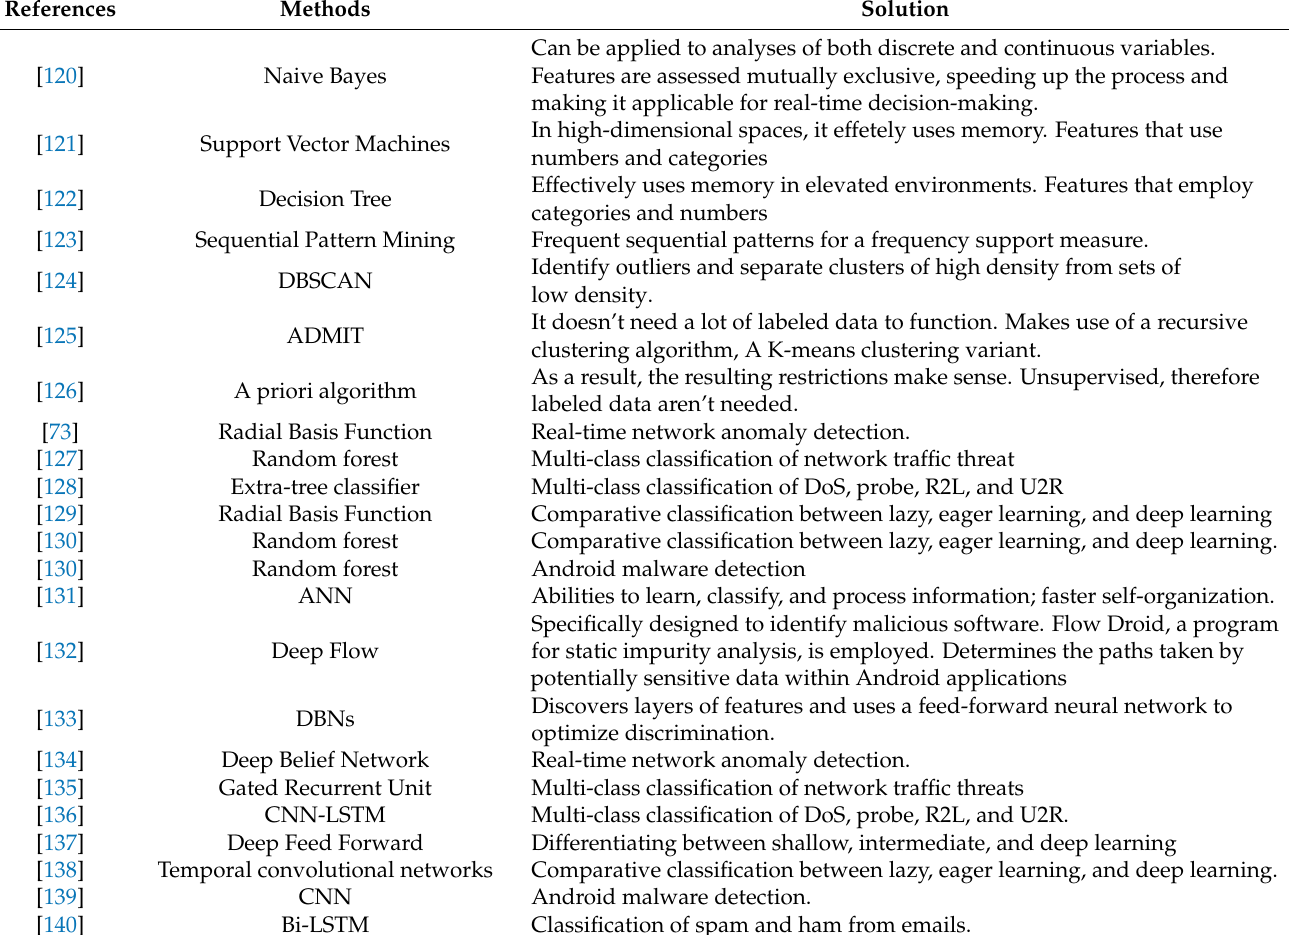
Table 6. Summary of different Machine Learning and deep learning